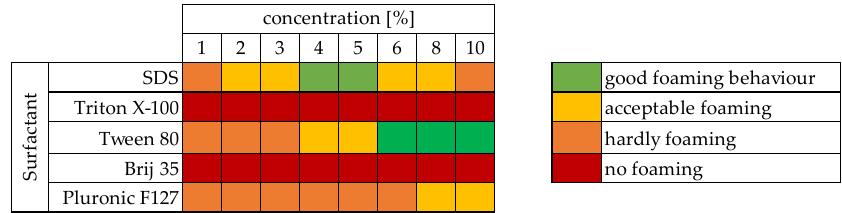
Figure 1. Heatmap of foaming behavior in dependence of surfactant type and concentration. Best results in terms of foam stability, homogeneity, and drying behavior were ob- served for 10% TWEEN-80 and 4% SDS. Other concentrations of these two surfactants did